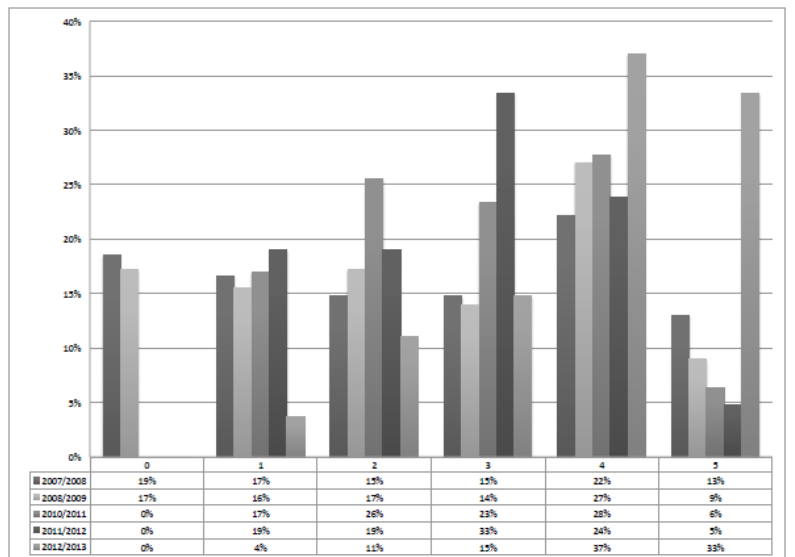
Figure 9. You have seen how JavaVis algorithms are implemented in the various methods explained in the lectures